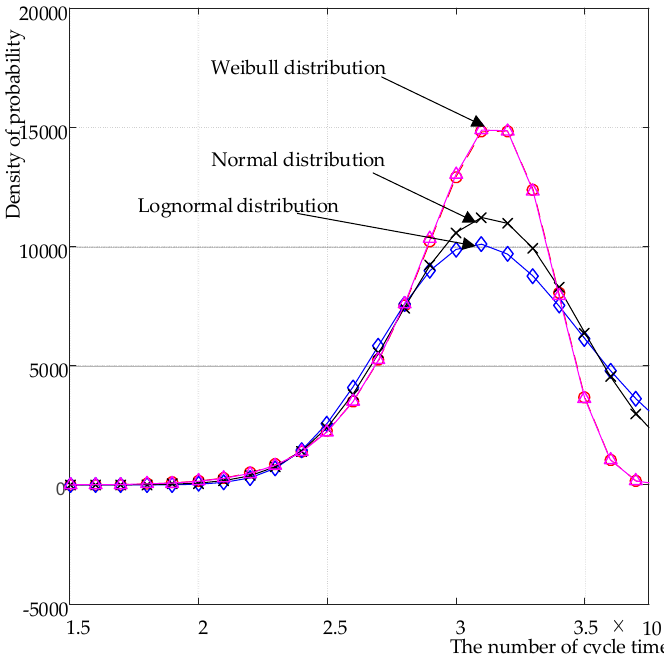
Figure 4. Comparison of the density function of Weibull distribution, Logarithmic Weibull distribution and normal distribution, lognormal distribution under the single-direction 1500 A fatigue test.